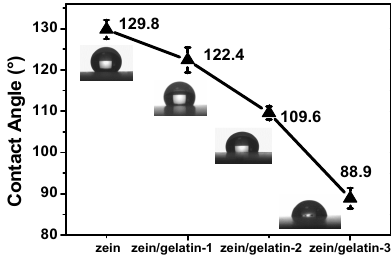
Figure 3. Contact angle pictures of zein, zein/gelatin-1, zein/gelatin-2, and zein/gelatin-3 electrospun nanofibers.